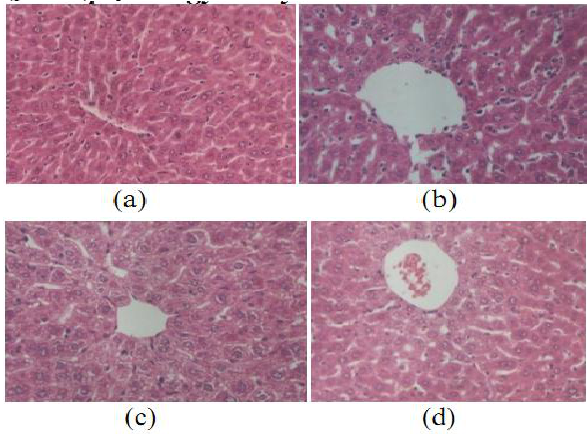
Figure 2. Liver histopahology of mice.